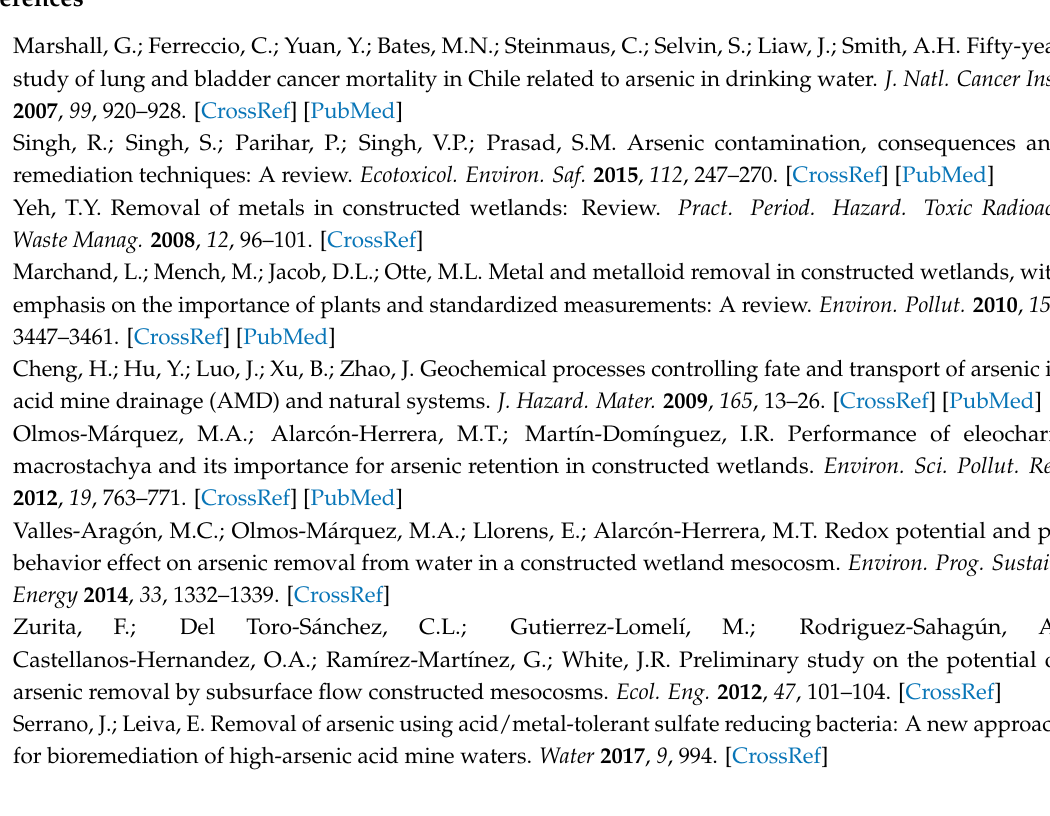
s1. Table S1: Saturation index values for relevant phases in the limestone cells for T = 20 ◦ C, Table S2: Saturation index values for relevant phases in the zeolite cells for T = 20 ◦ C, Table S3: Saturation index values for relevant phases in the limestone cells for T = 25 ◦ C, Table S4: Saturation index values for relevant phases in the zeolite cells for T = 25 ◦ C, Table S5: Saturation index values for relevant phases in the limestone cells for T = 30 ◦ C, Table S6: Saturation index values for relevant phases in the zeolite cells for T = 30 ◦